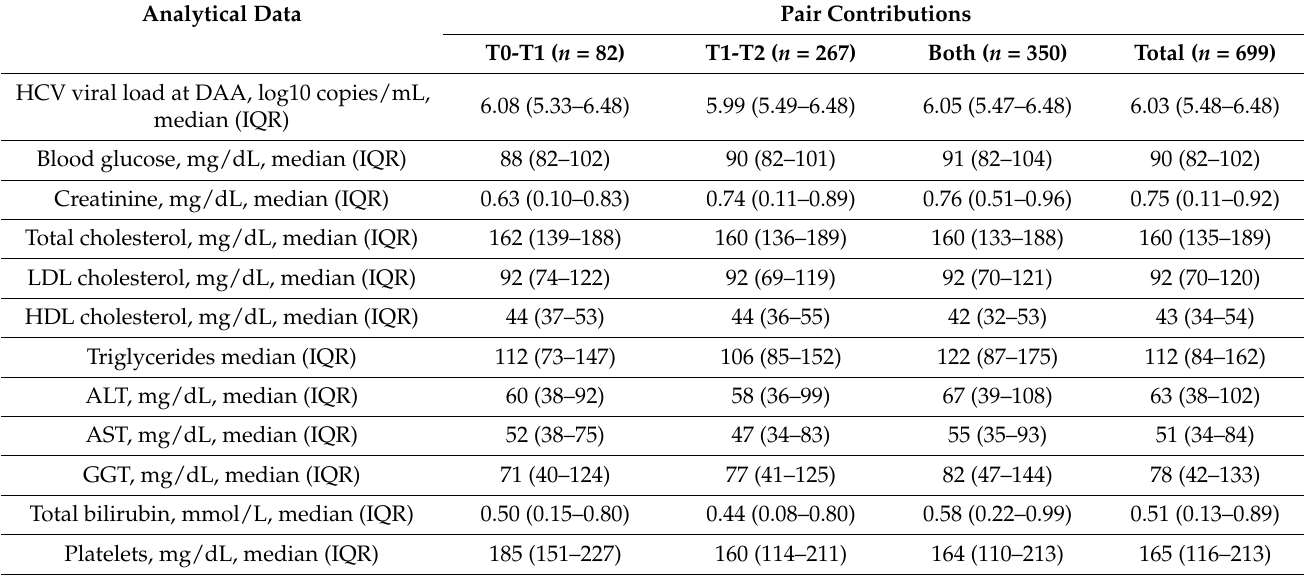
Table 2. Participants’ analytic data according to pair contributions. LDL: low-density lipoprotein cholesterol; HDL: high-density lipoprotein cholesterol; GGT: gamma-glutamyl transferase; and INR: international normalized